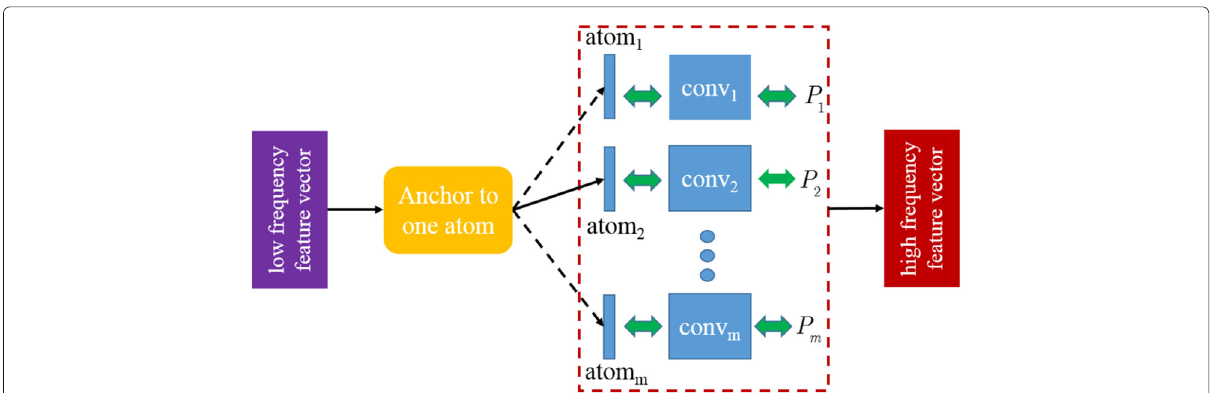
Fig. 2 Illustration of the anchored neighborhood convolution layer. Each input low-frequency feature vector will be anchored to one dictionary atom that will activate the corresponding convolution layer. Then, the activated convolution layer maps the low-frequency feature vector to the high-resolution space. The green double-headed arrow means each convolution layer is associated with one dictionary atom and a projection